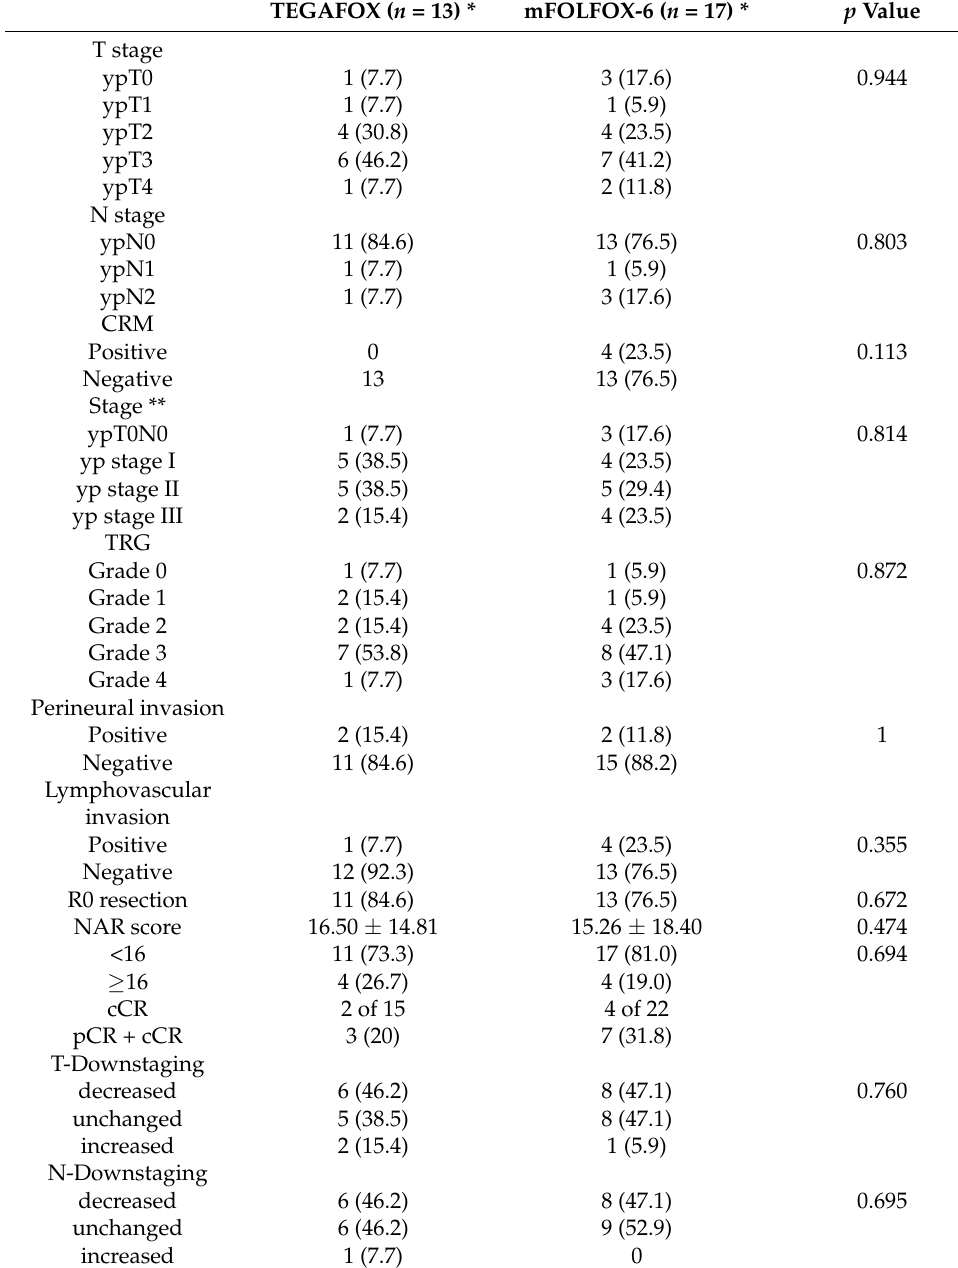
Table 2. Pathology findings by chemotherapy